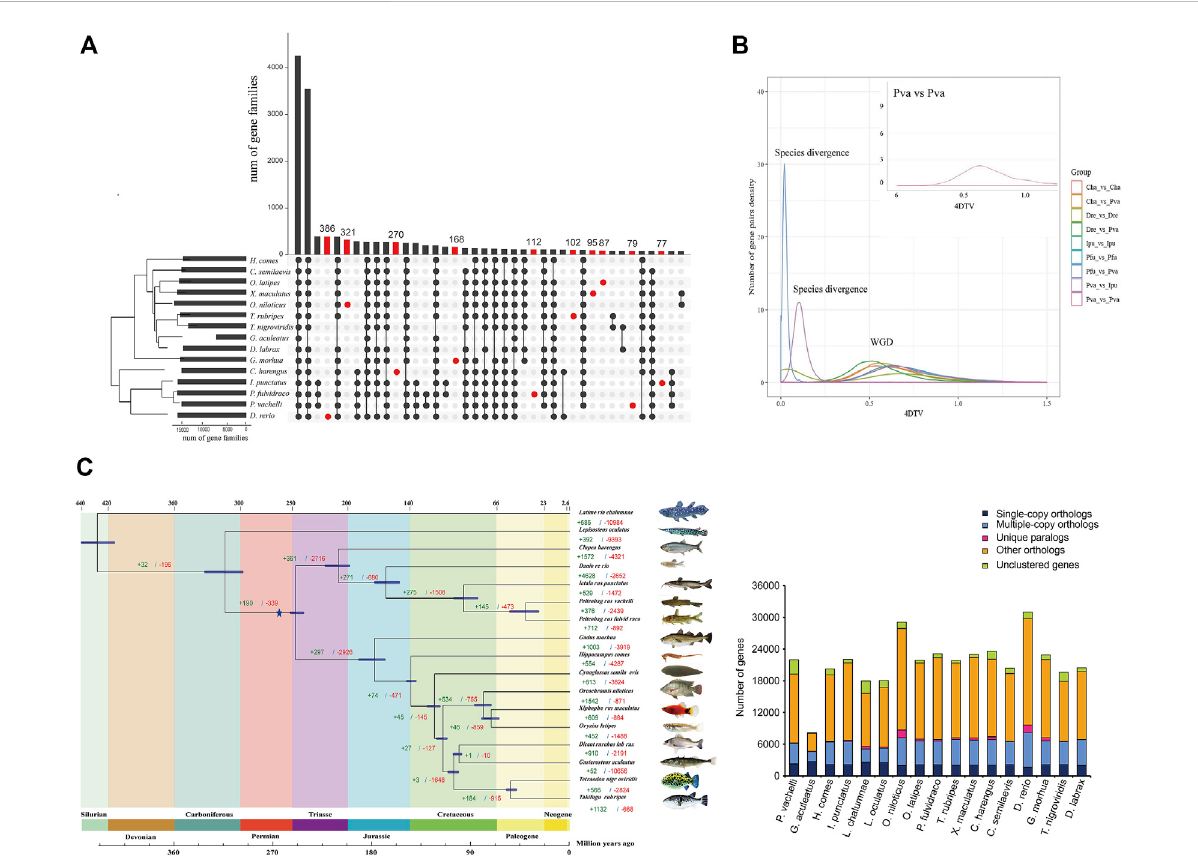
FIGURE 2 Comparative genomicsanalysisof P. vachelli . (A) An UpSet plotofgene families in P.vachelli aand other fi shes.The UpSet Plotwas drawn using the R package ‘ UpSet ’ . The abscissa of the horizontal bar chart represents the total number of gene families in each species, the ordinate represents the size of gene families, the red dots represent unique gene families, and the line segment represents the intersection relationship. (B) 4DTv prediction of the timing of WGD. Different colors indicate the comparisons between different species. Cha = Clupea harengus , Dre = Danio rerio , Ipu = Ictalurus punctatus, Pfu = Pelteobagrus fulvidraco, Pva = Pelteobagrus vachelli . (C) Inferred phylogenetic tree with 1,106 single-copy orthologs of 17 species identi fi ed by RAxML. Blue star represented whole-genome duplication (WGD) events. The green numbers represent the expansion gene familys and red numbers represent the contraction gene